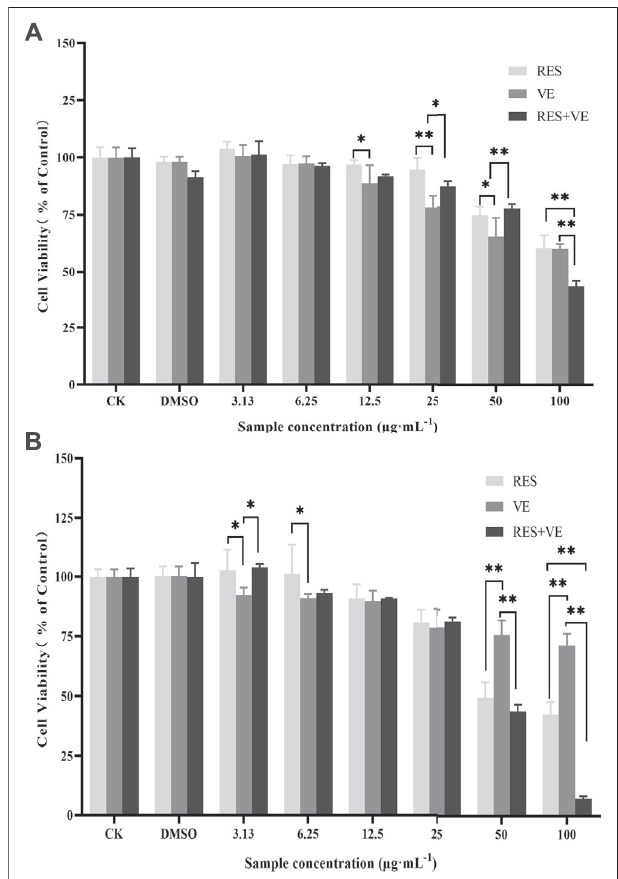
FIGURE 1 | Effect of resveratrol (RES) and Vitamin E (VE) on HCT-8 cell proliferation: Cell-counting kit-8 (CCK8) assay 24 h (A) and 48 h (B) . Note: * p < 0.05, ** p < 0.01, (Compared with the control